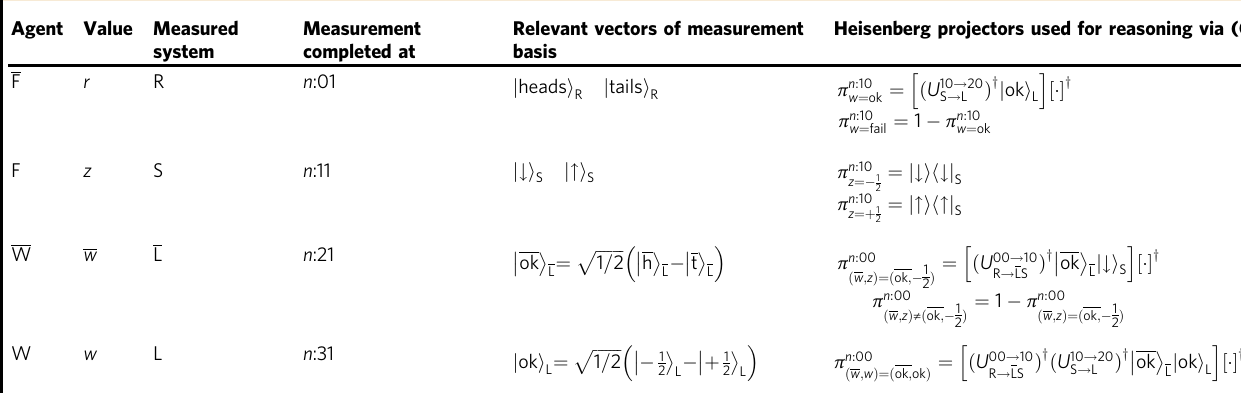
(cid:1) (cid:1) (cid:3) L and ok j i L showninthelasttworows are expressed in terms of states, such as (cid:2) 1